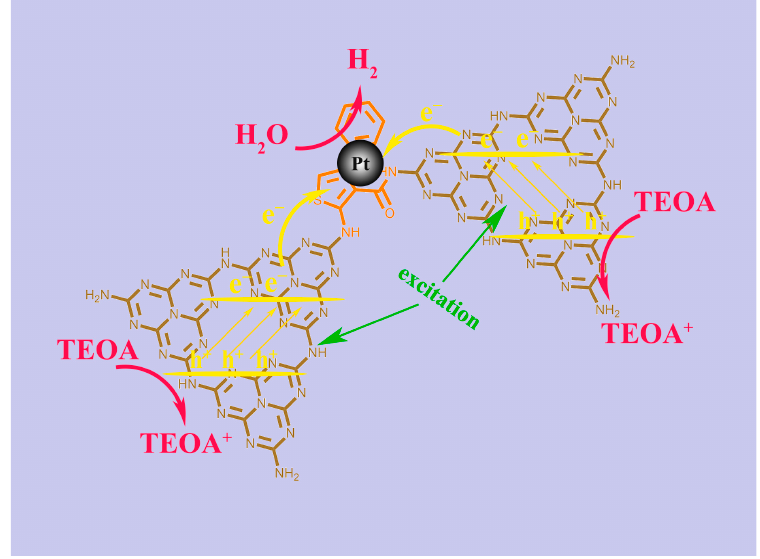
Figure 12. Possible photocatalytic H 2 evolution reaction mechanism of TA-CN.